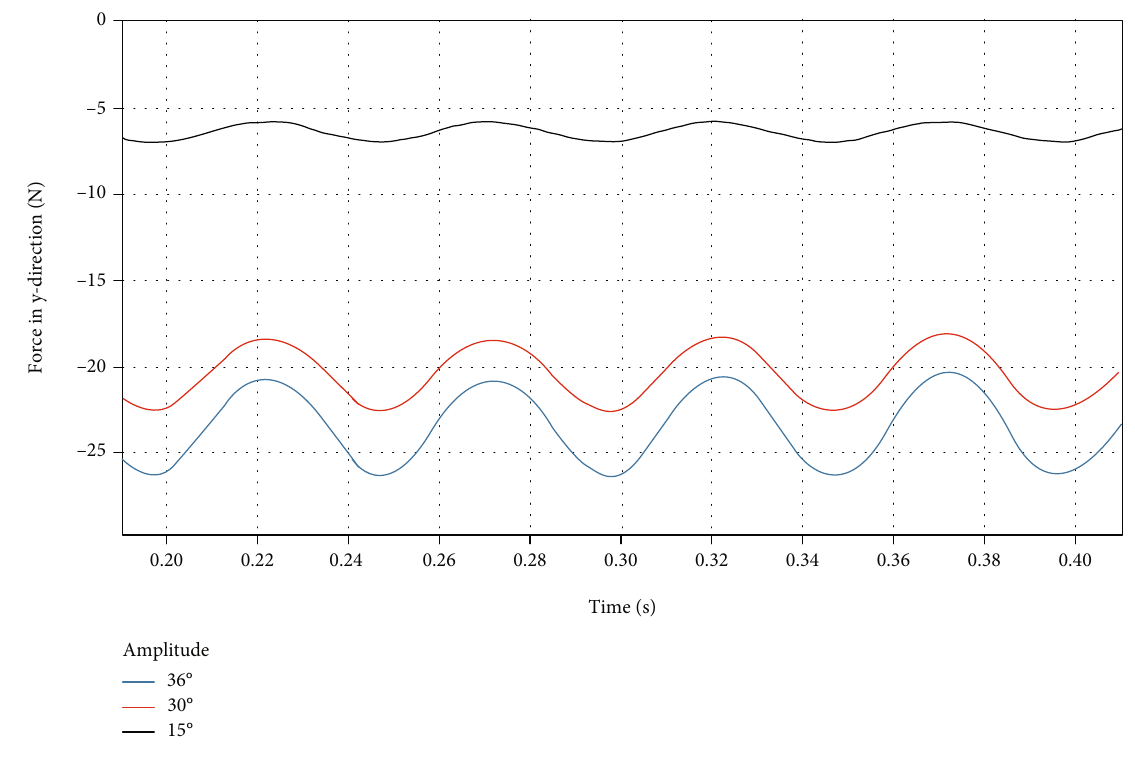
Figure 18: y -direction force on the dorsal fi n at di ff erent swing amplitudes. Table 11: y -direction force parameter values of the dorsal fi n at di ff erent swing